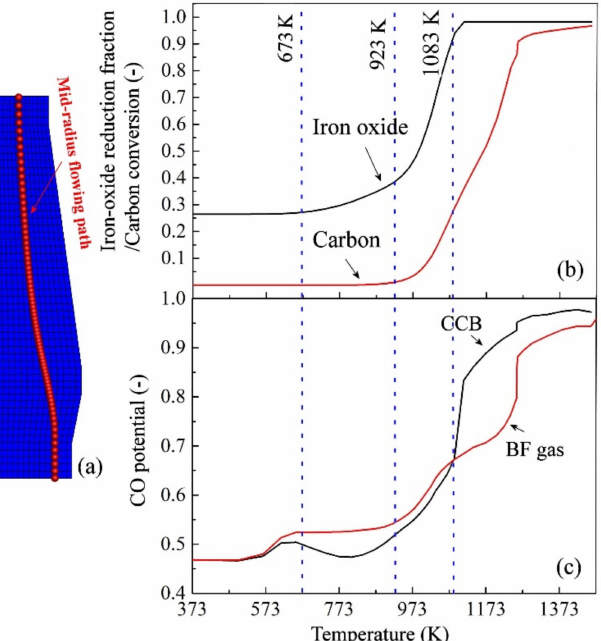
Figure 5. Reaction behavior of a single CCB: ( a ) illustration of the mid-radius solid flowing path, ( b ) changes of iron-oxide reduction fraction and carbon conversion in CCB along the path, and ( c ) changes of CO potential in CCB along the